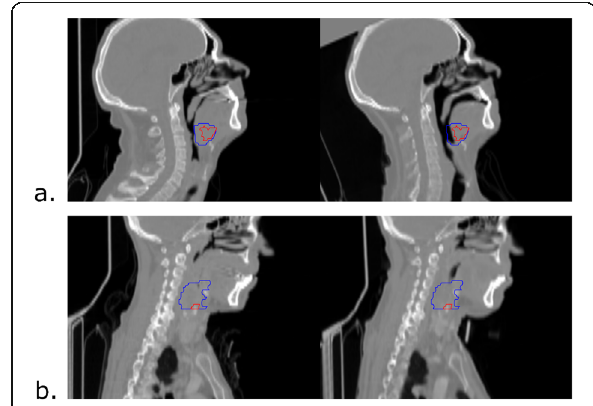
Fig. 3 Examples of both inaccurate and accurate structures matching. Left: pre-treatment CT. Right: post-treatment CT. a Inaccurate structures matching. Although the skull, the jaw, and the top of the spinal cord are aligned, the tongue of the patient appears in a different position between the two scans, leading to a misalignment of pertinent structures for tumor recurrence analysis. b Accurate structures matching. The skull, jaw and spinal cord are aligned and no anatomical differences between the soft tissues were found nearby the tumor. Blue: pre-treatment tumor. Red: post-treatment tumor